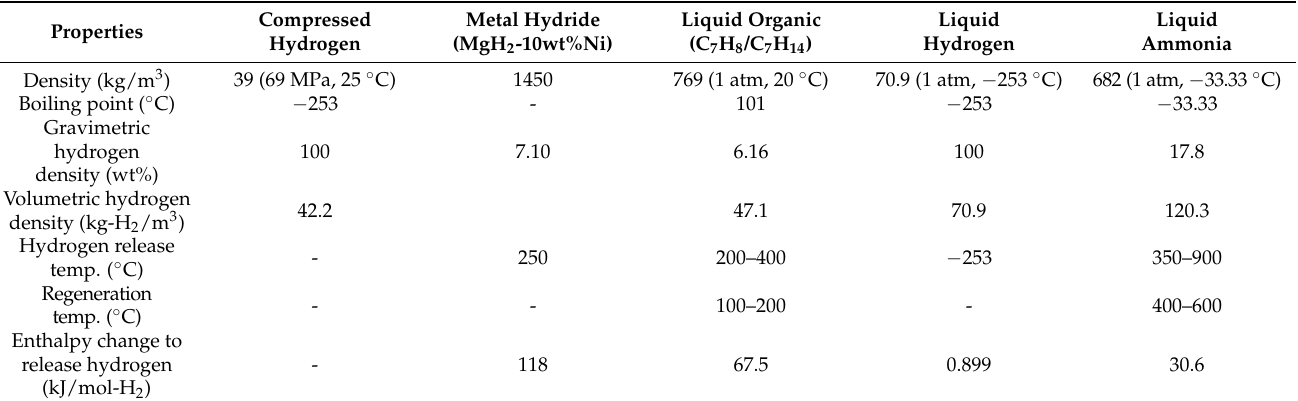
Table 2. Brief comparison of representative hydrogen storage technologies